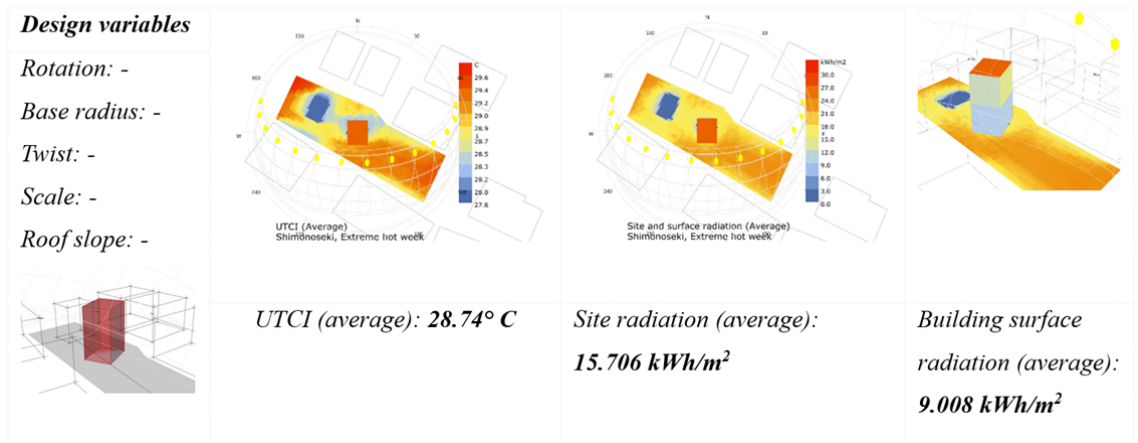
Fig. 5. Analysis results for benchmark model.